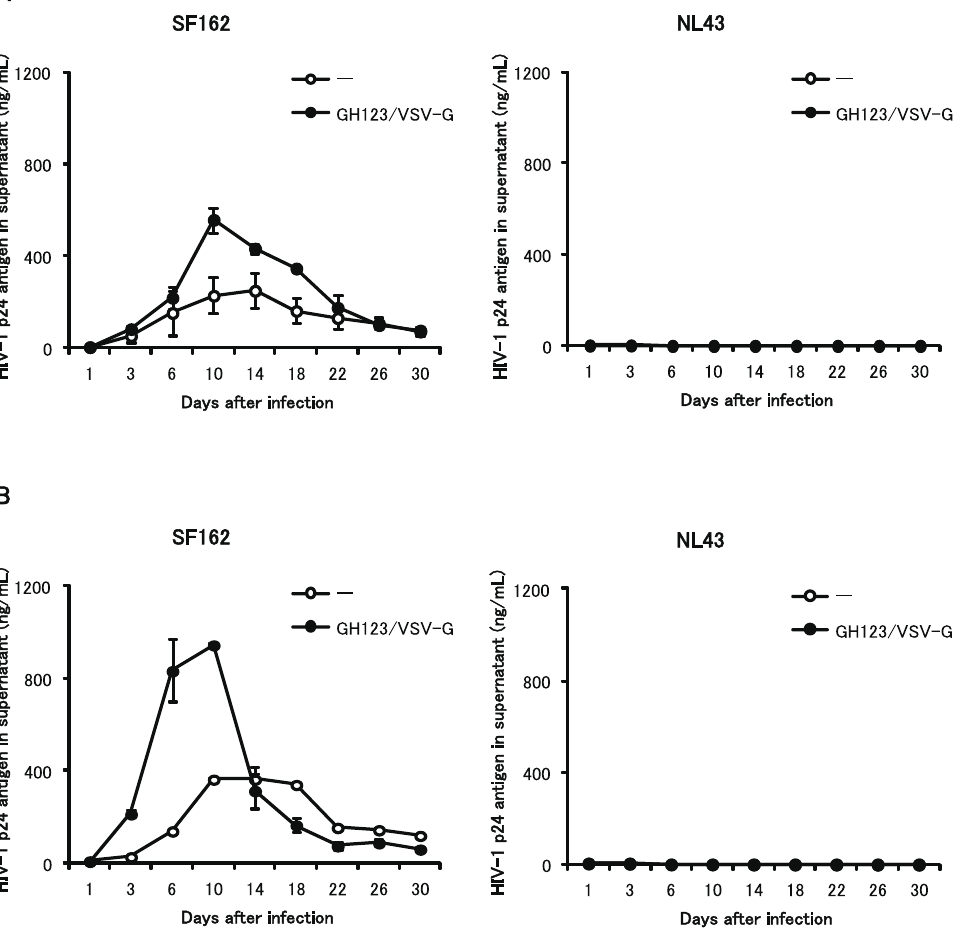
Figure 3. Effects of VSV-G-pseudotyped HIV-2 particles on macrophage-tropic and T-cell line-tropic HIV-1 strains in M-CSF-induced macrophages. Monocytes were differentiated into macrophages for 6 days in the presence of M-CSF. Macrophages were treated with VSV-G pseudotyped and Env-defective HIV-2 particles (GH123/VSV-G) and then infected with HIV-1 strain SF162 or NL43. HIV-1 replication was quantified by ELISA measurement of p24 antigen in the supernatant after infection. Data are plotted as the mean 6 SD of triplicate samples; presented data are representative of two independent experiments using two donors. A: Results of samples obtained from a donor 1. B: Results of samples obtained from a donor